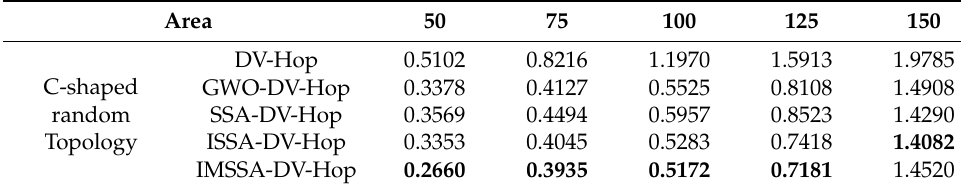
Table 9. Localization error in different Area in C-shaped random Table 8. Localization error in di ff erent Area in square random topology.